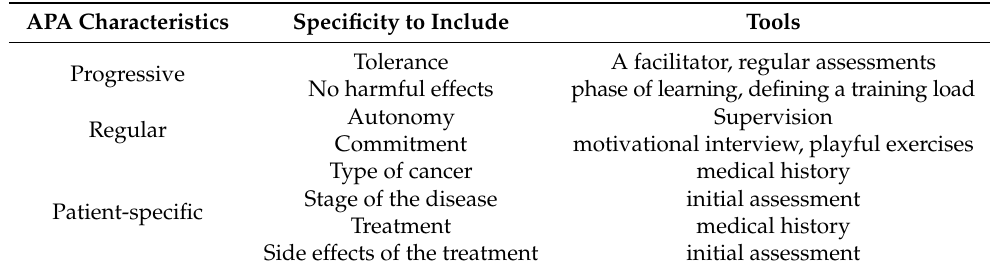
Table 3. Recapitulating the adapted physical activity principle and the tools to facilitate the